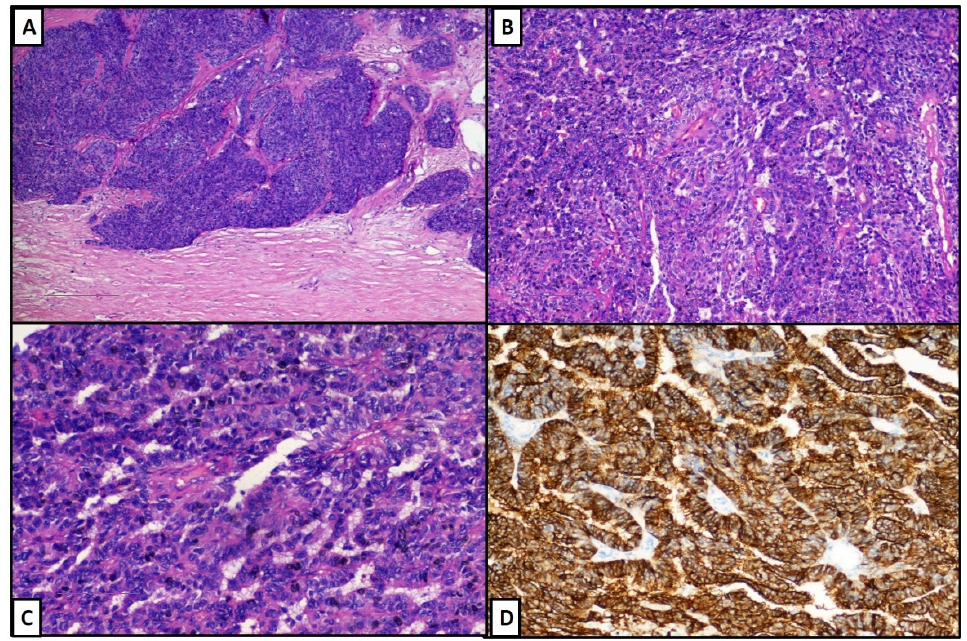
Figure 1. ( A , B ) Axial and coronal projections. Large meningioma in the left parietal area of 5 × 5 cm. The mass is surrounded by perifocal oedema with consecutive compression and dislocation to the right of the ventricular system. The temporal horn of the ipsilateral ventricle results in communica- tion with the subarachnoid space. The administration of the gadolinium determines inhomogene- ous accentuation of the mass. ( C , D ) PM displays an heterogenous hyperintensity in DWI sur- rounded by an hypointense oedema.